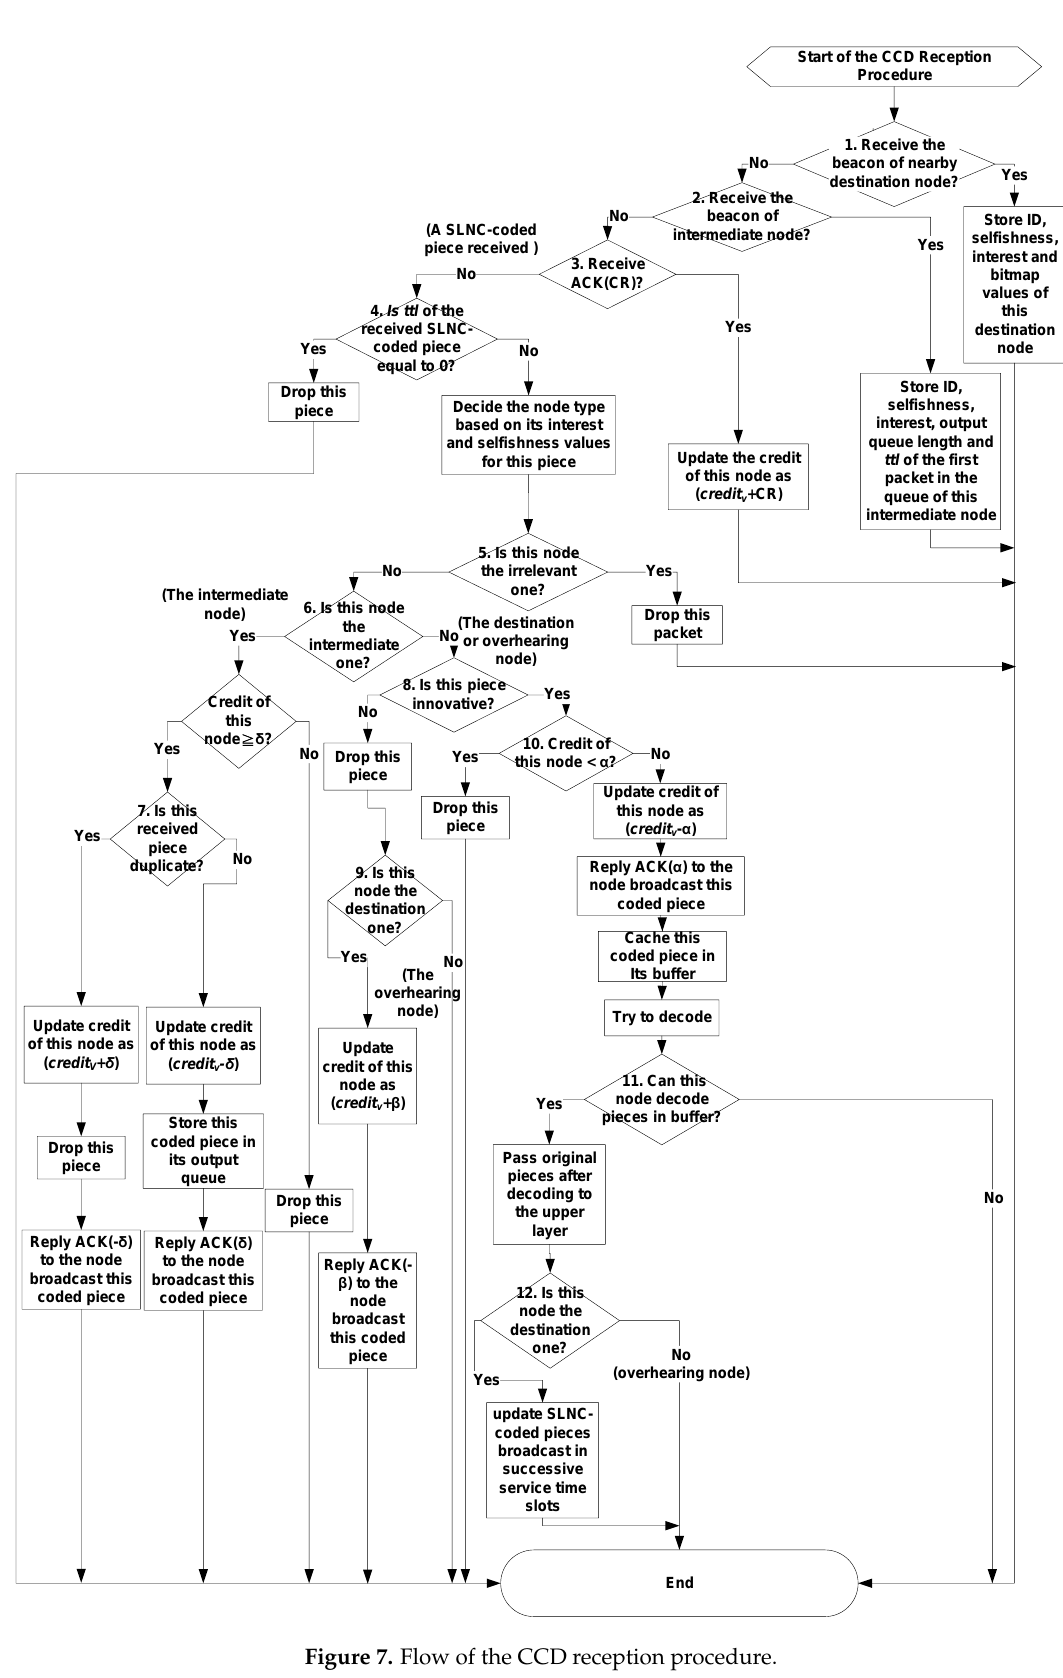
Figure 7. Flow of the CCD reception procedure.